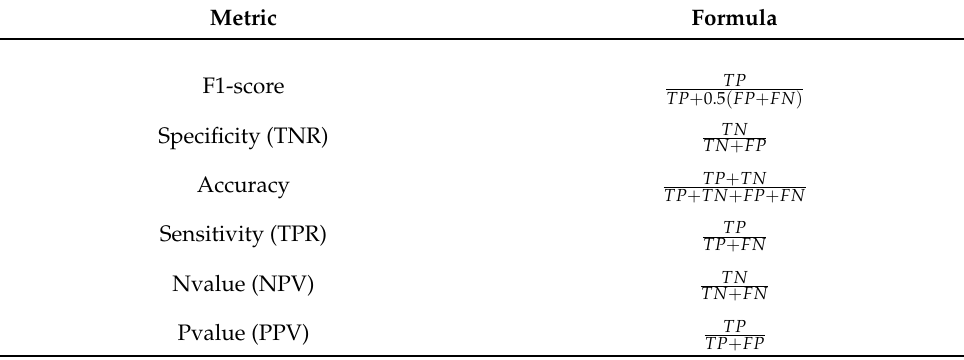
Table 5. Evaluation metrics used in assessing the proposed optimized voting classifier.